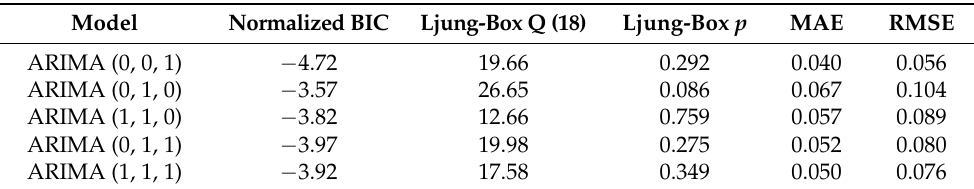
Table 1. Model Comparisons.